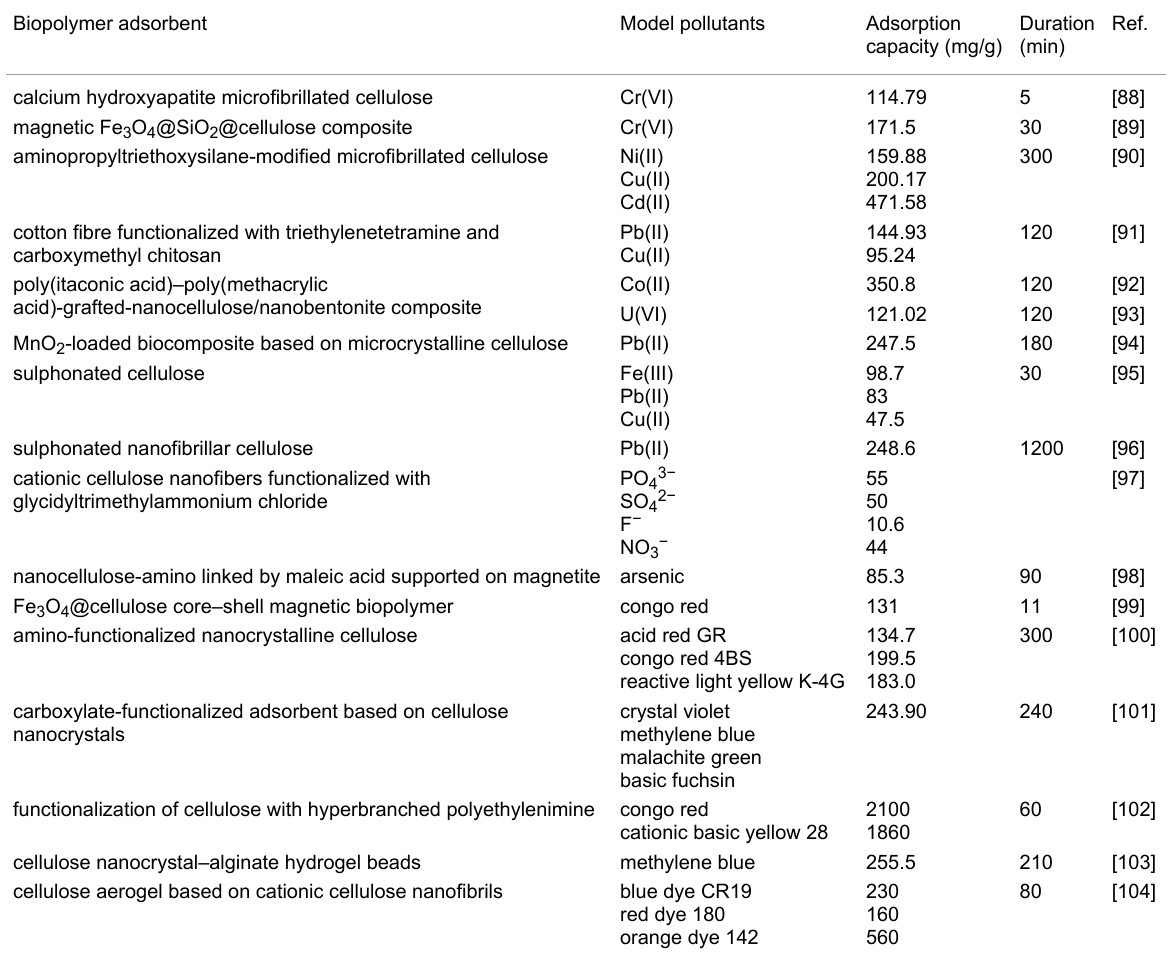
Table 1: Cellulose-based biopolymer adsorbents for various types of organic pollutants. Biopolymer adsorbent Model